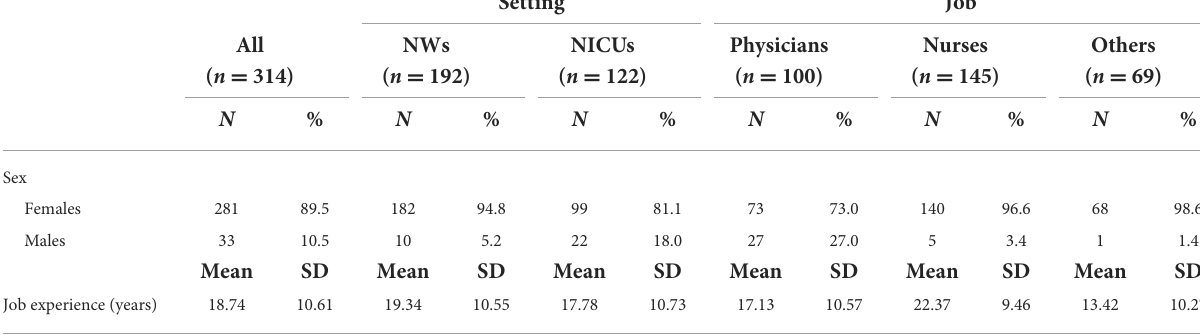
TABLE 1 Socio-demographic variables of the study